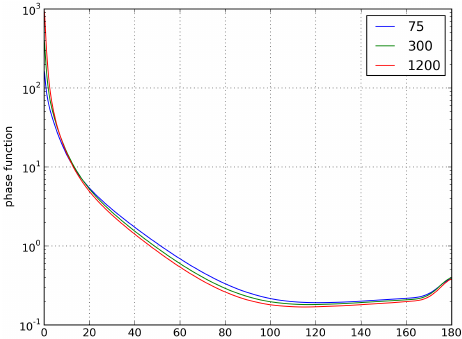
Figure 3. Phase functions of desert aerosol at 0.8µm, with a mix- ture of the non-spherical mineral components MINM, MIAM and MICM after the Eqs. (2)–(4), using the total number of mineral par- ticle N mineral given in the figure. In each case 2000 WASO particles assuming 0% RH are included.